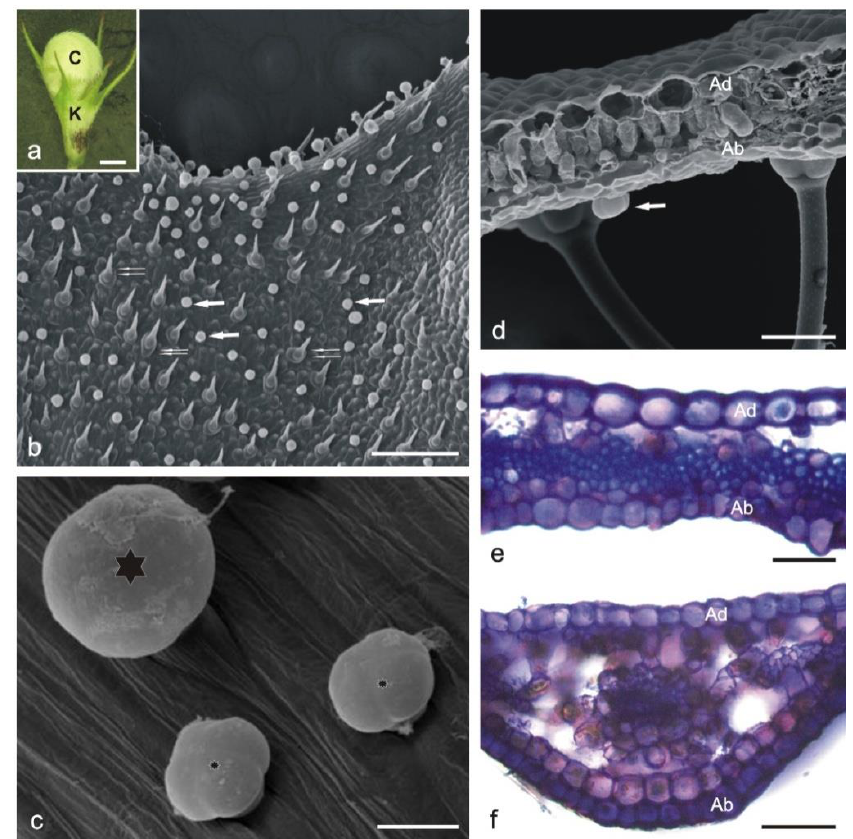
Figure 3. General habit and fragments of the L. album subsp. album calyx. ( b – d )—SEM; ( e , f )—LM. ( a ) Flower bud with an open calyx. ( b ) Glandular (arrows) and non-glandular (double arrows) trichomes on the abaxial surface of the calyx. ( c ) Peltate trichome (large asterisk) and capitate trichomes (small asterisks) on the abaxial surface of a sepal nerve. ( d ) Cross section of a sepal with fragments of two non-glandular trichomes and a glandular trichome (arrow) on the abaxial surface. ( e , f ) Cross sections of sepals (Toluidine blue O staining). Abbreviations: K calyx, C corolla, Ad adaxial epidermis, Ab abaxial epidermis. Scale bars: 2 mm ( a ), 200 µm ( b ), 50 µm ( d – f ), 20 µm ( c ).